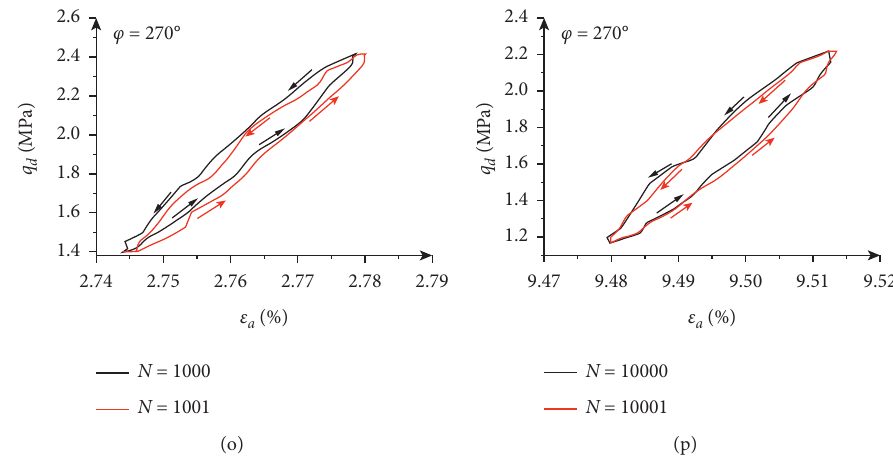
Figure 15: The hysteresis loops of different principal stress phase differences.